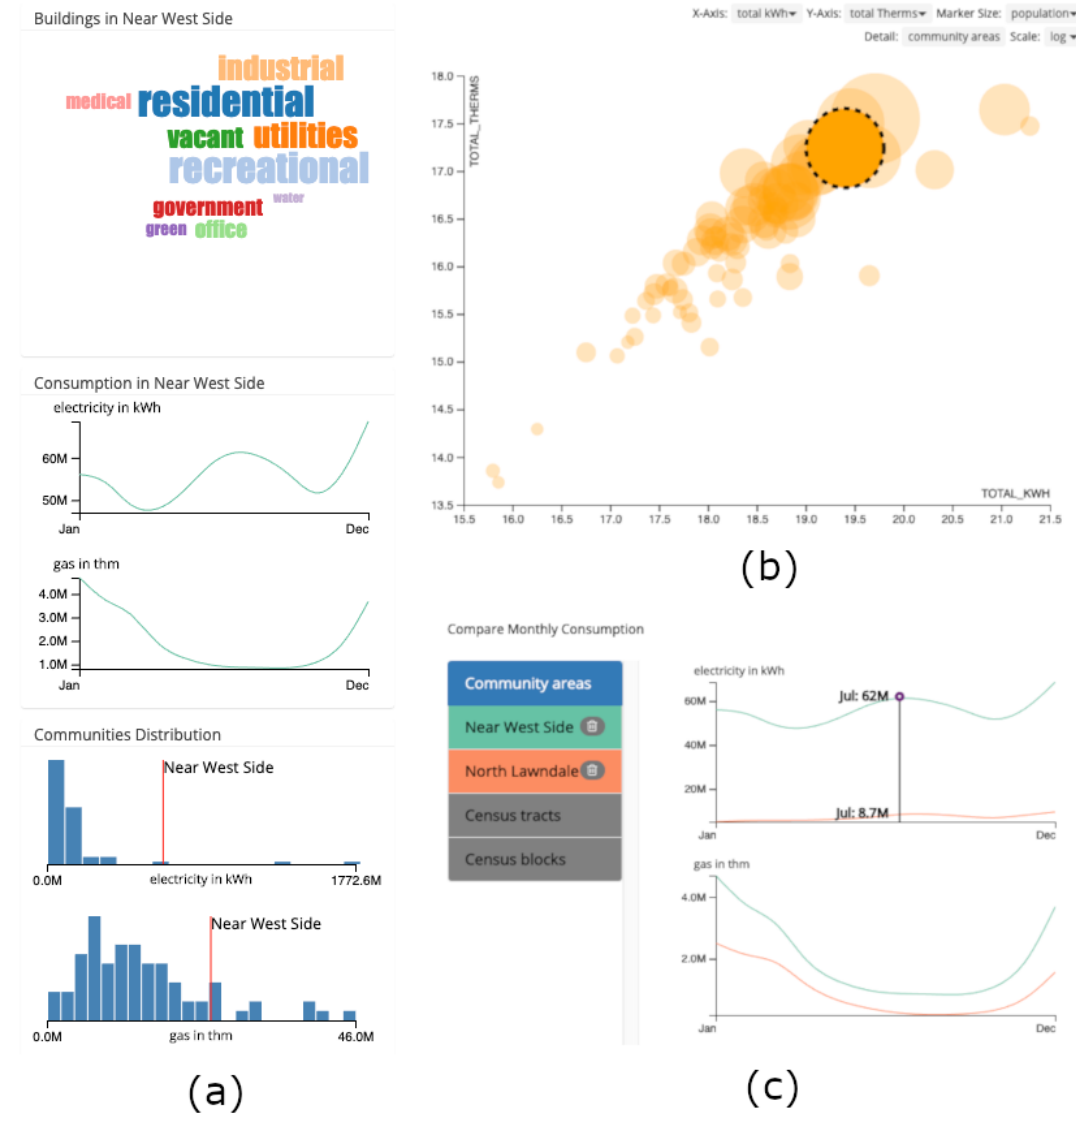
Figure 4. Visual encodings and interactions for urban energy consumption analysis: ( a ) a word cloud shows the distribution of buildings in a neighborhood; underneath, charts and histograms show energy consumption across seasons, respectively the relative rank of the selected neighborhood against the 76 neighborhoods in the city. ( b ) A scatterplot supports outlier detection; bubbles along the two main axes show regions for which either gas or electricity data is not available. ( c ) A comparison panel supports direct comparison of multiple user selected regions, again across